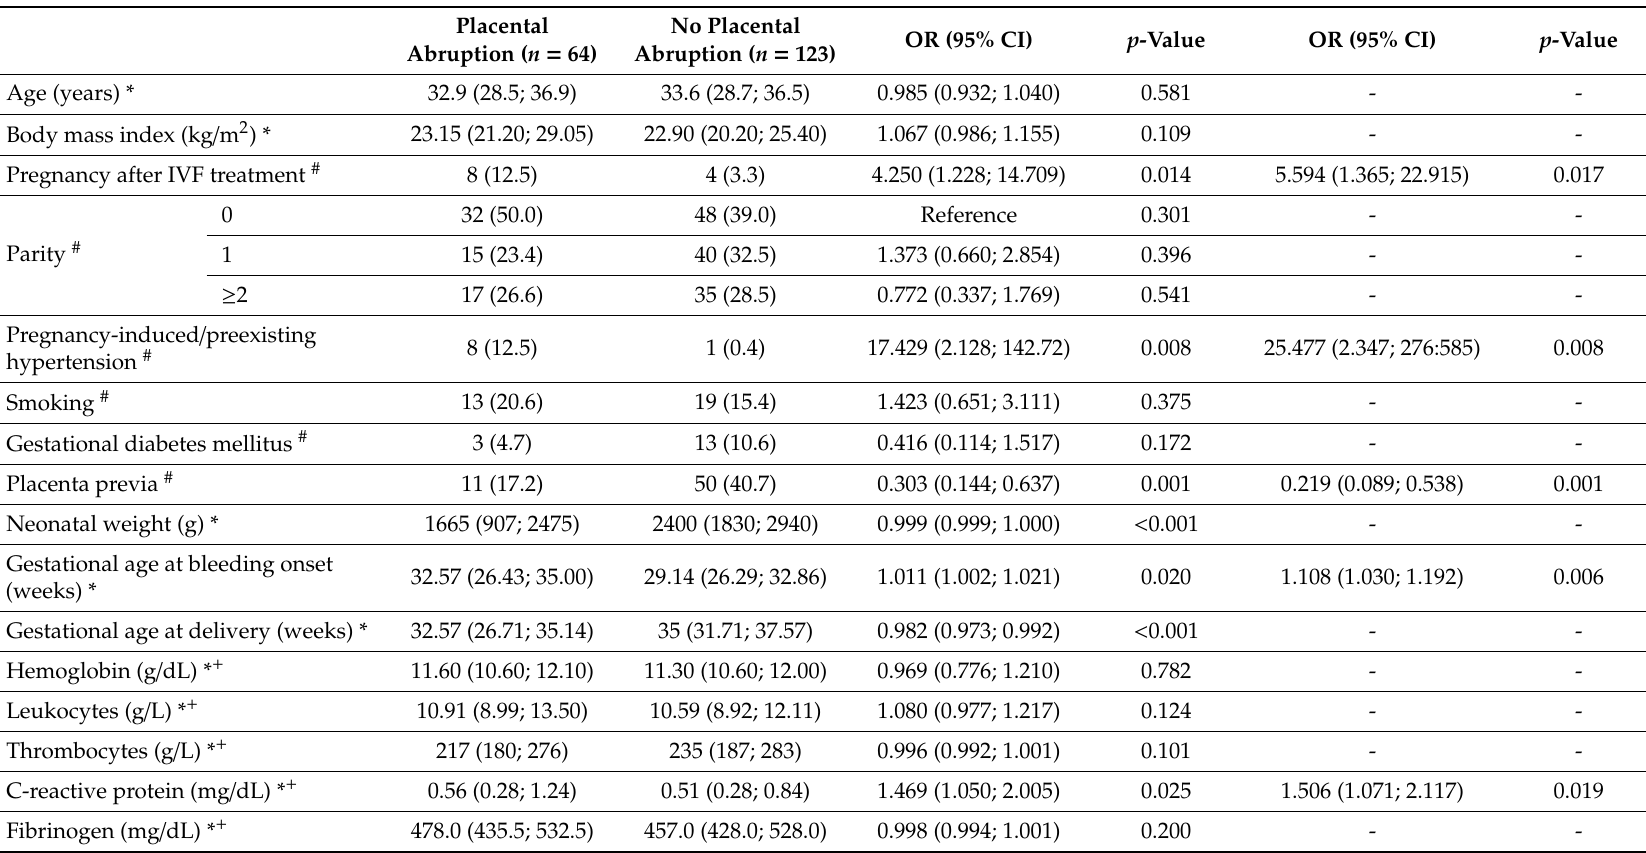
Table 2. Women with and without placental abruption who presented with vaginal bleeding: comparison of basic patient characteristics and laboratory parameters at the time of bleeding